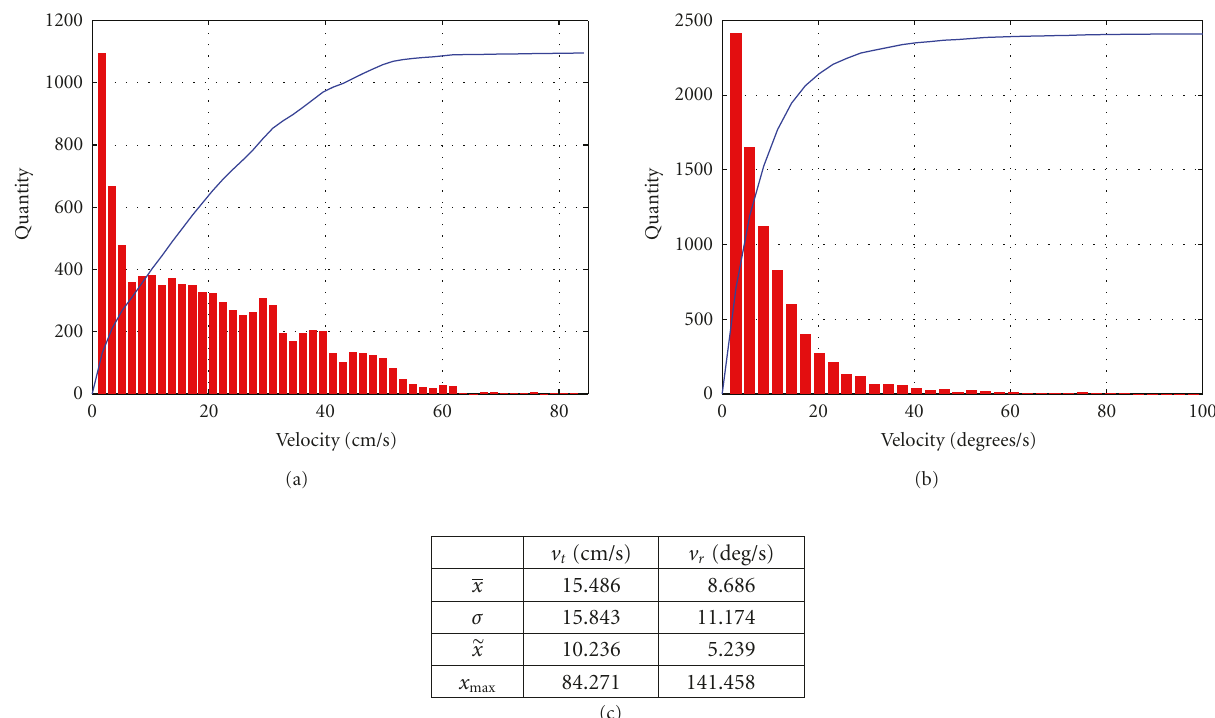
Figure 11: Histogram of translational ( v t ) and rotational ( v r ) velocities of movements of a user acting in a CAVE-like environment. The blue line depicts the cumulative percentage of the measurements. In (b), we limited the upper bound to 100 degrees/s for better readability, (c) shows the descriptive statistics about the